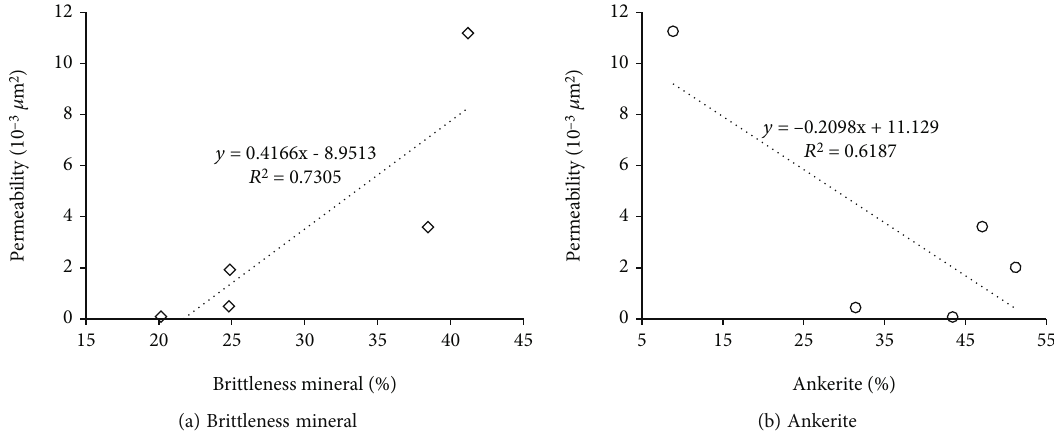
Figure 4: Relationship between rock composition and